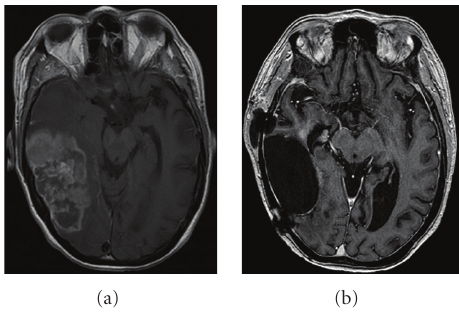
Figure 2: (a) Axial contrast-enhanced MR image of the cerebrum showing a 3 . 8 × 7 . 8 cm tumor infiltrating the parietooccipital region of the right hemisphere. The lesion is with surrounding edema and compressing the right lateral ventricle and the right side of the mesencephalon. (b) Four weeks after start of treatment, a resection cavity with a modest enhancement against the calvaria is seen. The centre line is in normal position, and the content of the cavity is isodense with the cerebrospinal